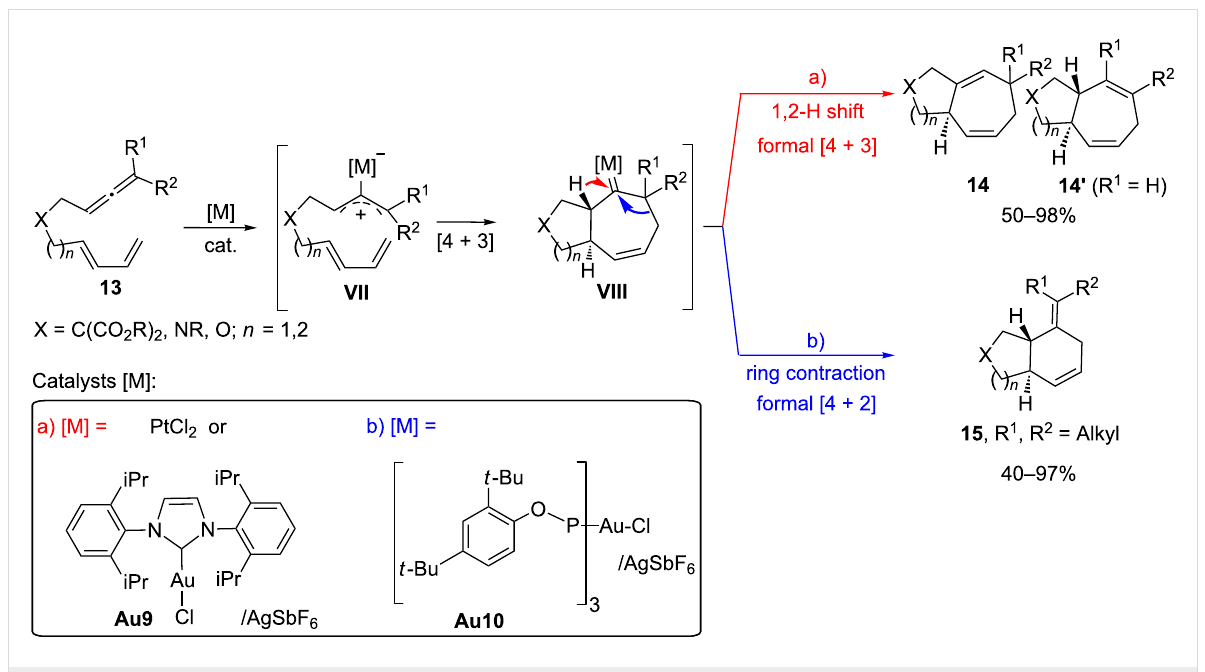
Scheme 8: Gold-catalyzed allenediene [4 + 3] and [4 + 2]